Question: Identify the chart type used in this figure.
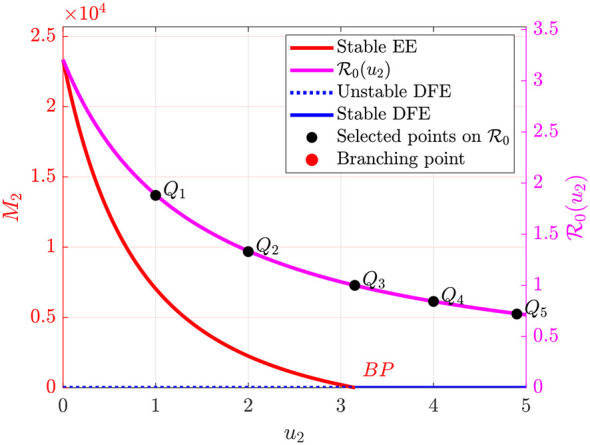
Answer: line